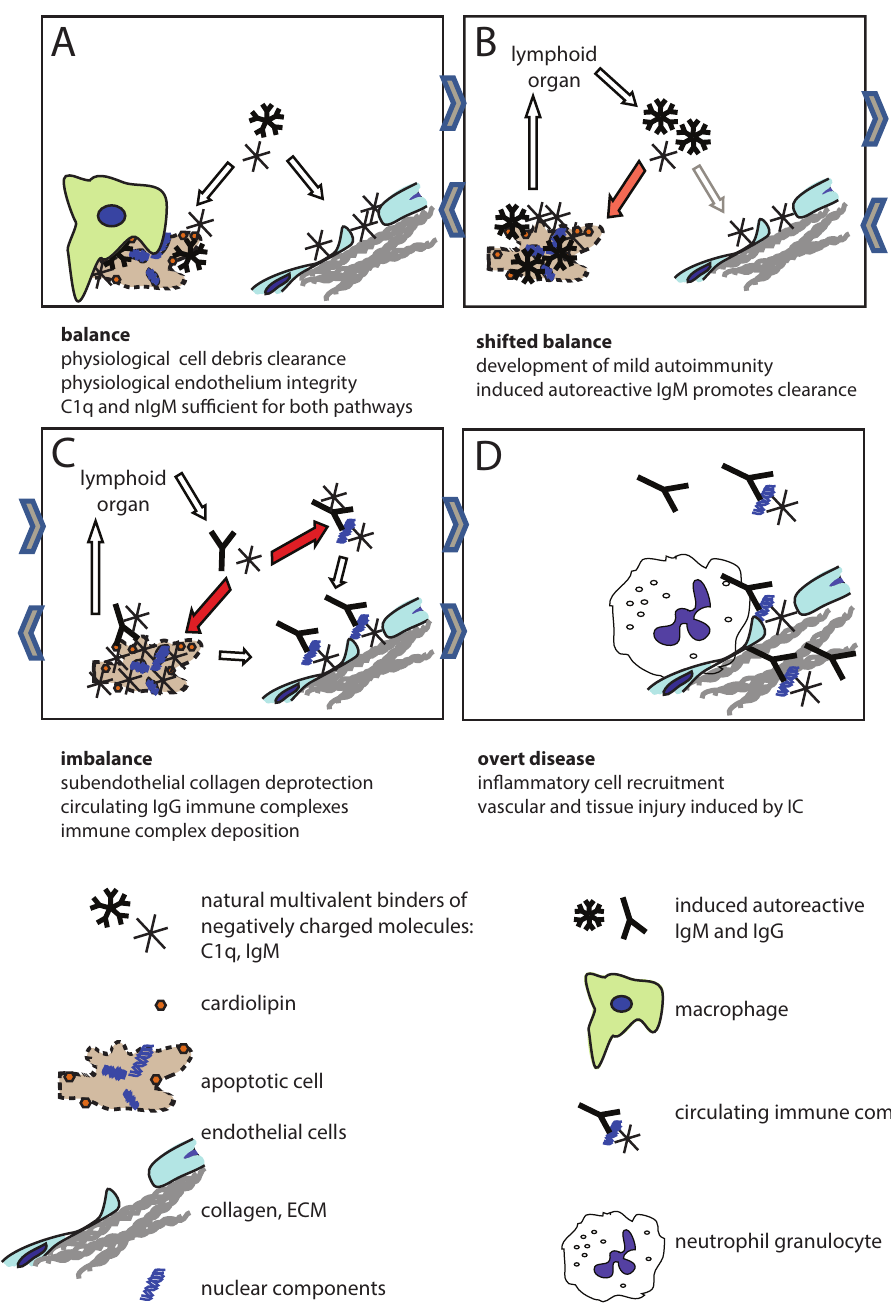
Figure 3. The endothelial deprotection hypothesis. Maintenance of endothelial integrity and clearance of cellular debris both requires multimeric innate molecules (C1q, nIgM) with the ability to bind anionic surfaces ( A ). C1q binds to fenestrated regions of the endothelial cell and to collagen exposed due to leaky endothelial junctions. Increased use of these innate molecules by the clearance mechanism, or deficiency of these molecules shifts this balance, which results in cellular debris reaching the lymphoid organs ( B ). This triggers the production of IgM against the autoantigens. Induced autoreactive IgM binds to apoptotic autoantigens, activates the complement system and promotes clearance. Sustained autoantigenic stimulus and genetically determined clearance deficiency coupled with tendency of mounting inflammatory immune responses will result in the production of IgG against the tissue derived autoantigens ( C ). Immune complexes containing IgG and C1q will bind to the vascular wall, since free C1q levels are low and circulating immune complexes will outcompete them. Deposited immune complexes containing IgG recruit white blood cells with Fc γ receptors, which can trigger cell activation, release of inflammatory cytokines, frustrated phagocytosis, NETosis ( D ). Immune complexes and autoantibodies can penetrate the tissues via the damaged endothelium, causing organ specific damage. Sustained inflammation leads to irreversible organ damage. Orange and red arrows indicate mild and strong redirection of C1q usage, respectively. Arrows in between figure boxes indicate reversibility ( A – C ) or irreversibility ( C – D